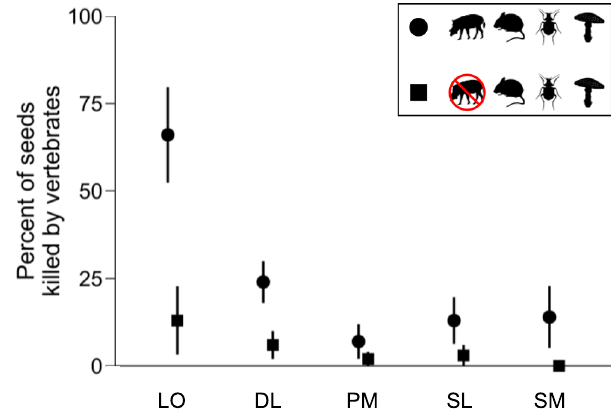
Fig. 4 Seed predation. Differences in seed predation by large and small vertebrates (circles) vs. small vertebrates only (squares); error bars show mean values ± standard errors across experimental blocks ( N = 10). Predation was determined by physical signs or seed removal and limited to the period prior to establishing as seedlings (i.e., excluding trampling). LO = Dimocarpus longan , DL = Dryobalanops lanceolata , PM = Parashorea malaanonan , SL = Shorea leprosula , and SM = Shorea macrophylla . Excluding large mammals signi fi cantly decreased vertebrate predation (mixed-effects logistic regression: P < 0.001). Overall vertebrate mortality did not signi fi cantly differ only for PM ( P = 0.083). This suggests that large vertebrates are signi fi cant seed predators for LO, DL, SL, and